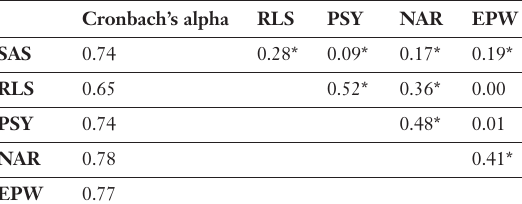
Figure 1 Histogram of Epworth score distri- butions among male and female pharmacy customers.